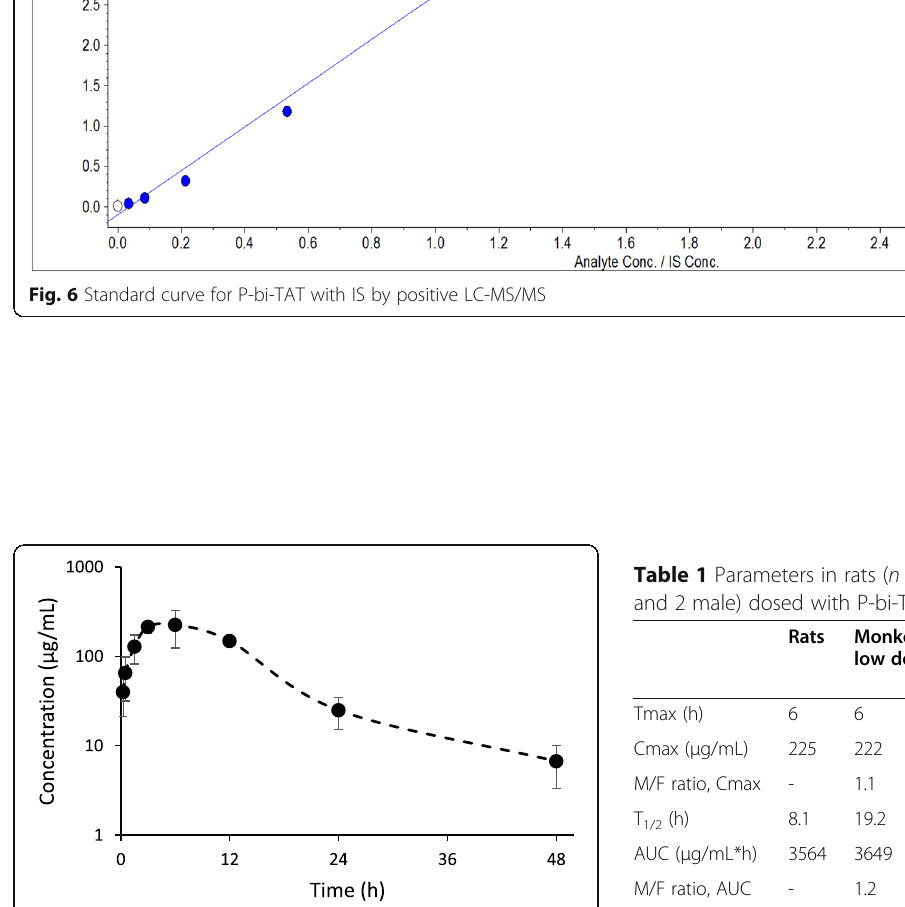
Fig. 7 Time course of plasma levels of P-bi-TAT (10 mg/kg) in rats n = 4. Error bars represent standard errors of the mean